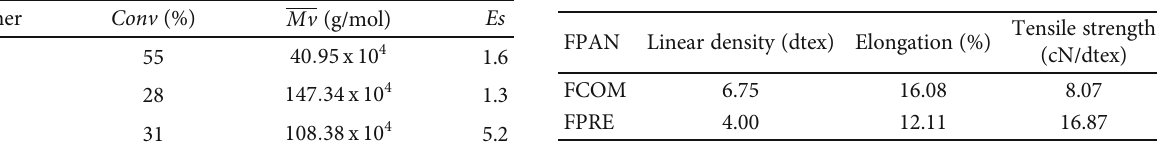
Table 7: Properties of new terpolymers of PAN.